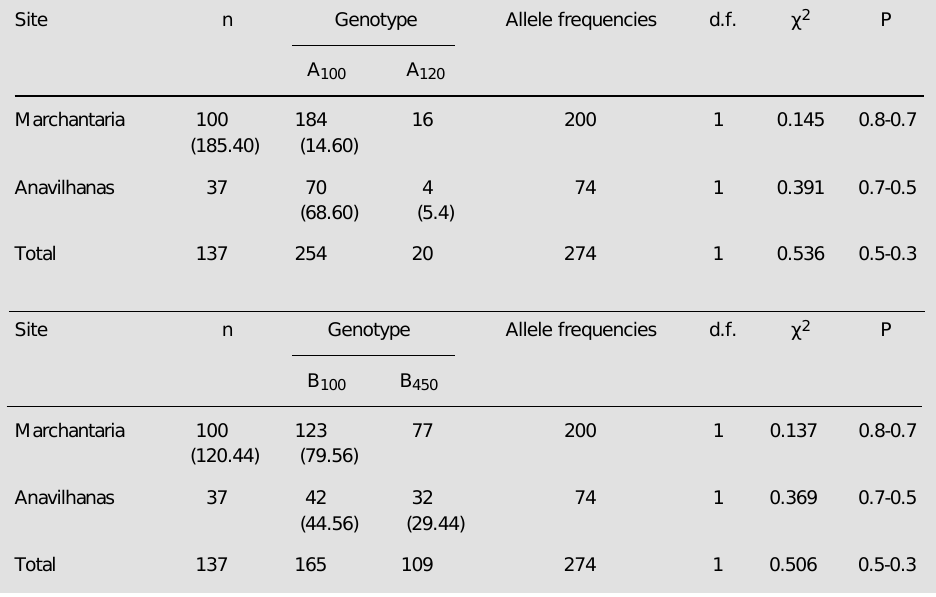
Table 2 - Contingency analyses of the homogeneity of PGI-A and PGI-B alleles of Callophysus macropterus from Marchantaria Island and Anavilhanas